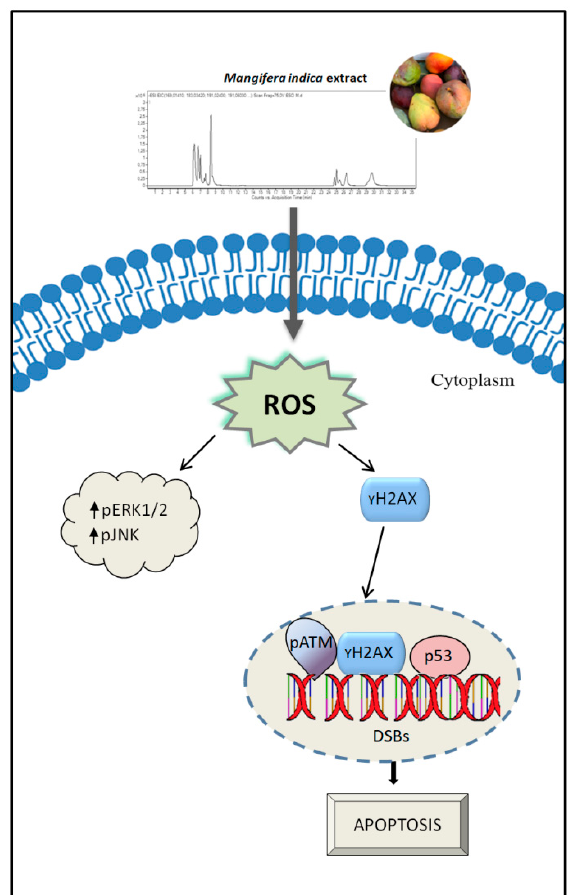
Figure 10. Schematic representation of the mechanism of action of MPE on colon cancer cells. MPE treatment promotes oxidative stress injury evidenced by ROS generation and activation of stress-mediated responses (pERK1 / 2 and pJNK) as well as DNA fragmentation. The activation of γ H2AX in response to DNA damage causes the commitment to apoptotic demise.